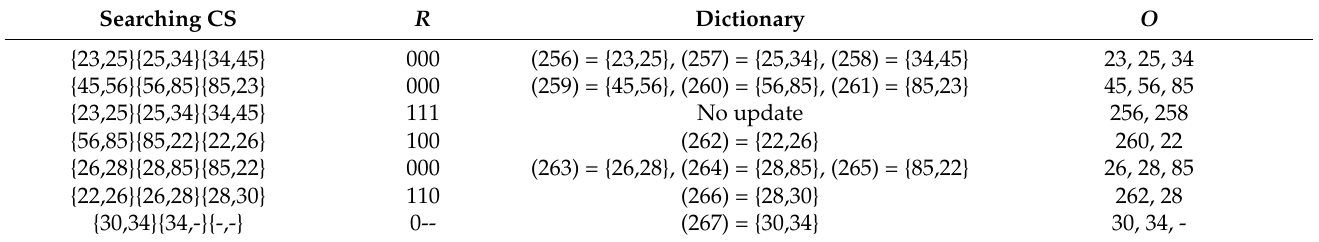
Table 3. Coding process of the MCS-based LZW algorithm.